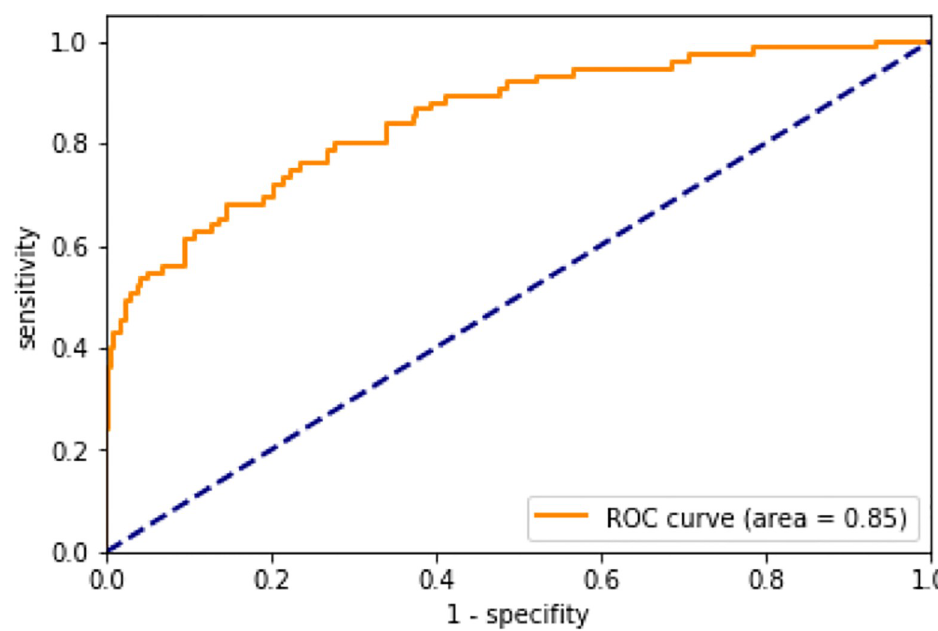
Fig 1. Receiver operating characteristic (ROC) curve of the proposed skin classifier tested on the ISBI 2016 challenge data.